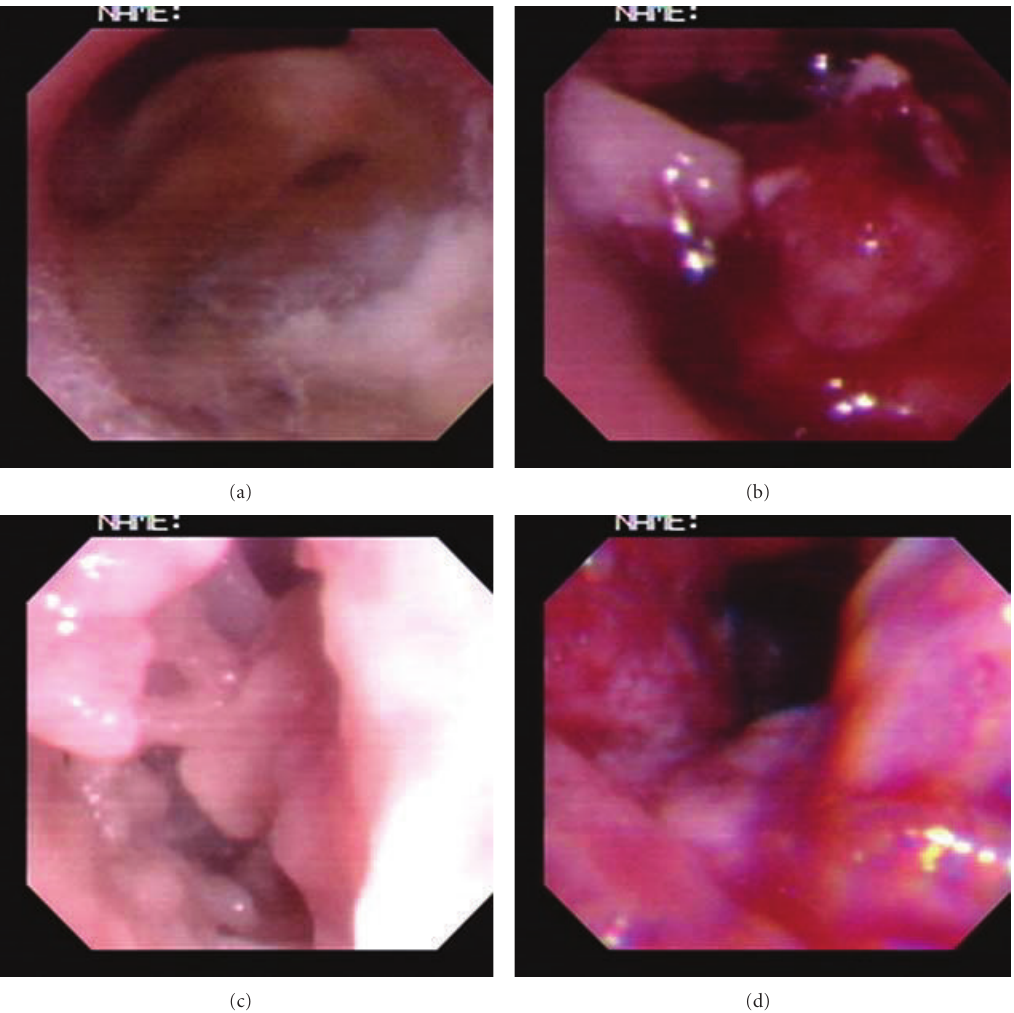
Figure 2: Bronchoscopic view of the right middle bronchus; (a) obstructed bronchus; (b) mass lesion; (c) necrotic material behind mass; (d) after the removal of necrotic